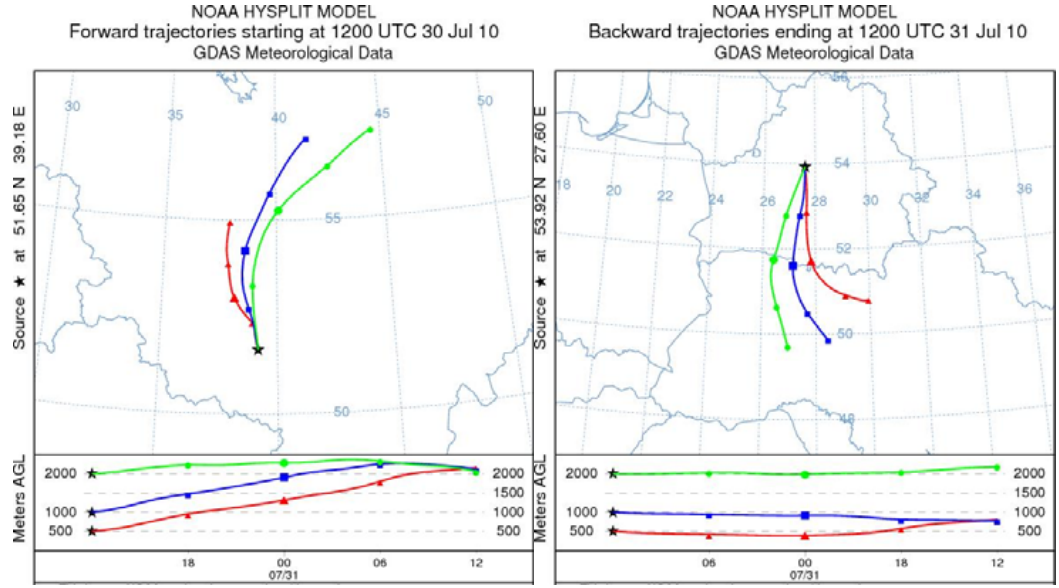
Fig. 9. Air flow trajectories for a 24h time interval with 6h temporal resolution obtained from the HYSPLIT model. Left: forward trajectories for air masses originating near the Voronezh Oblast starting on 30 July 2010 at 12:00 UTC; Right: backward trajectories of air masses reaching Belarus on 31 July 2010 at 12:00 UTC.